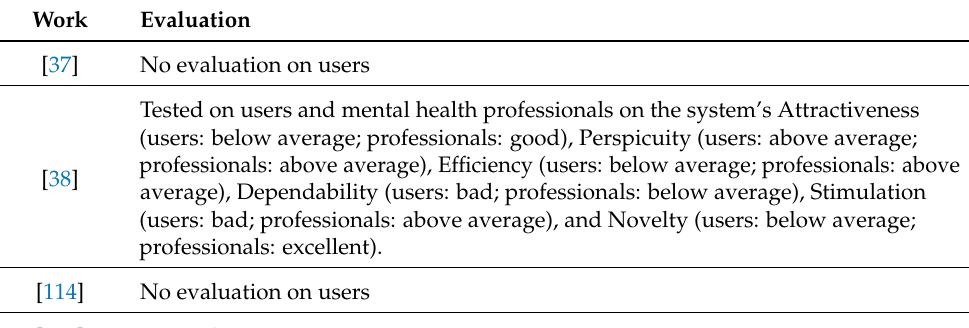
Table 9. Answering RQ8. How are the systems evaluated in terms of ABC for